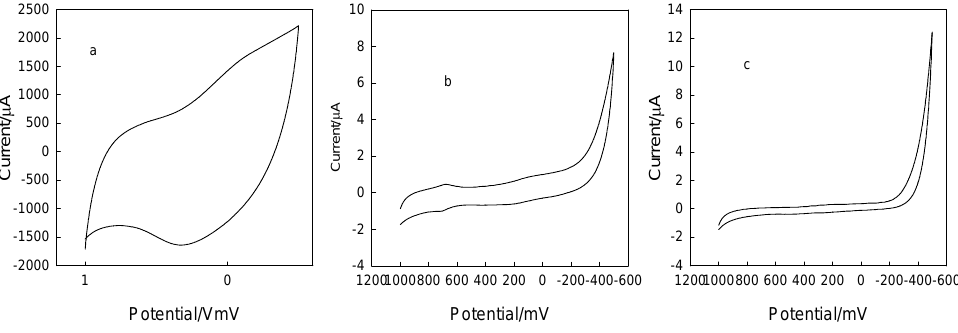
Figure 6. Cyclic voltammograms obtained with the CLTNPE (a), GC (b) and CPE (c) in